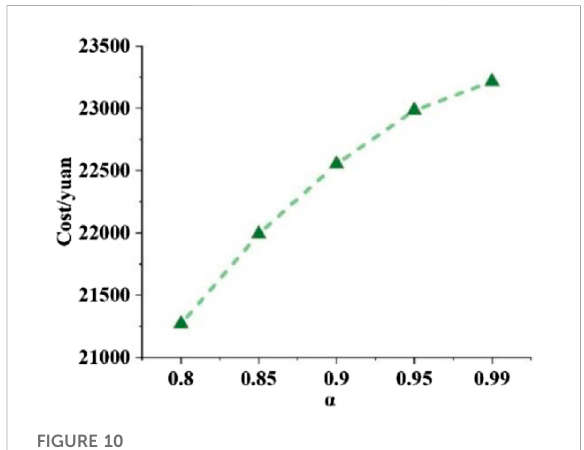
FIGURE 10 Relationship between total cost and con fi dence level α